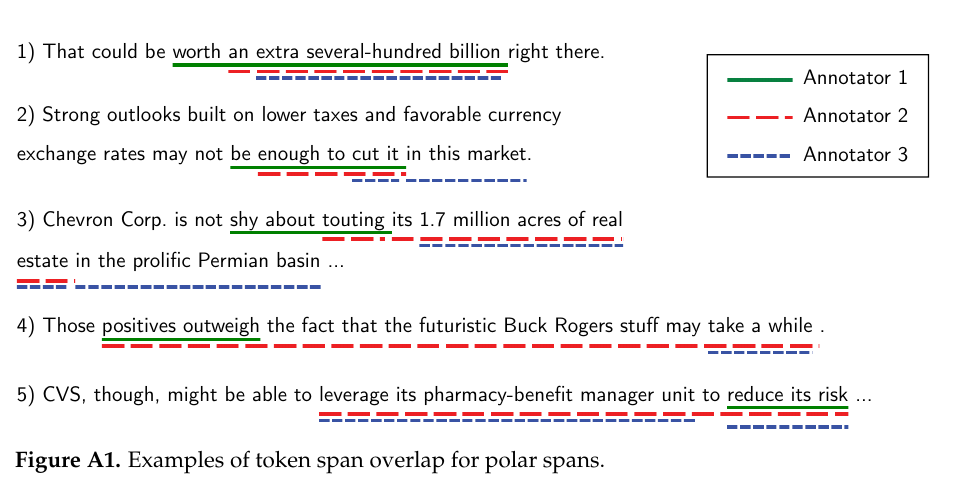
Figure A2. Example of exact span overlap of the same